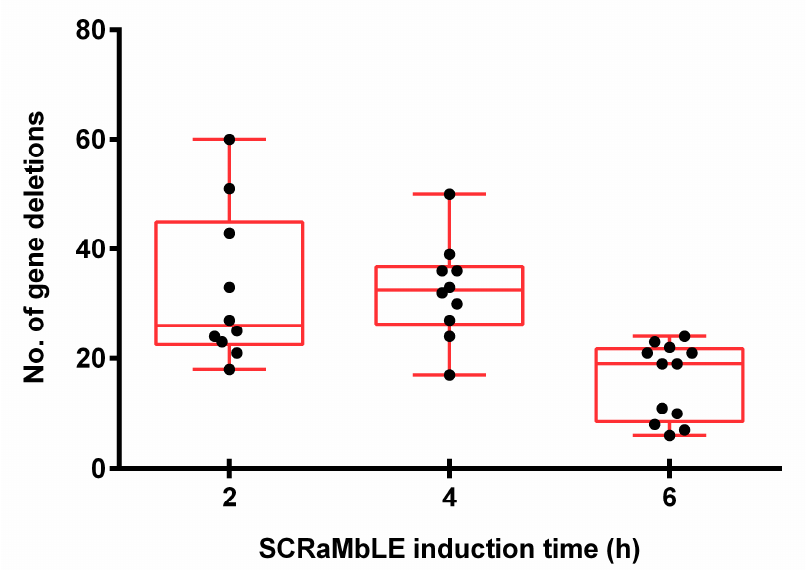
Figure 6. The number of deleted genes in white EW01_GAL colonies obtained after two, four or six hours of estradiol exposure. Each black dot represents an individually sequenced SCRaMbLEd EW01_GAL colony.